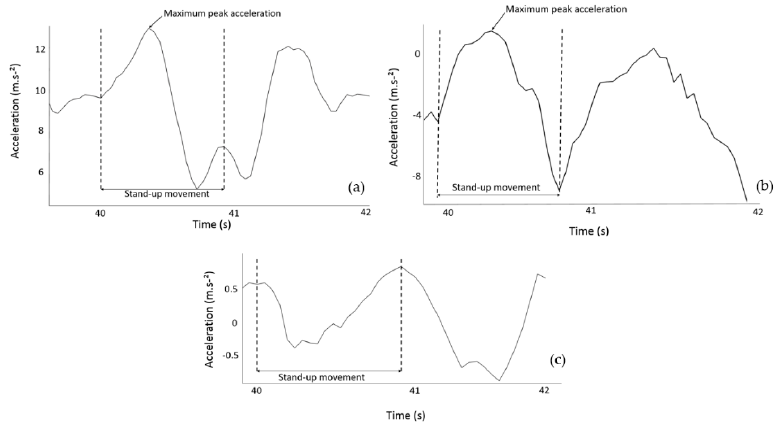
Figure 2. Acceleration signals from the glasses during a sit-to-stand movement in comfort speed without cervical collar on the three different axes: ( a ) vertical, ( b ) anteroposterior, and ( c ) mediolateral. Graphs a and b show the maximum acceleration peaks during the stand-up movement.